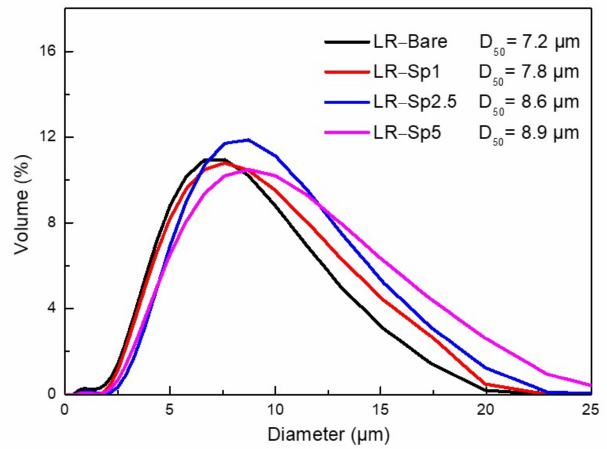
Figure 3. Size distribution of each